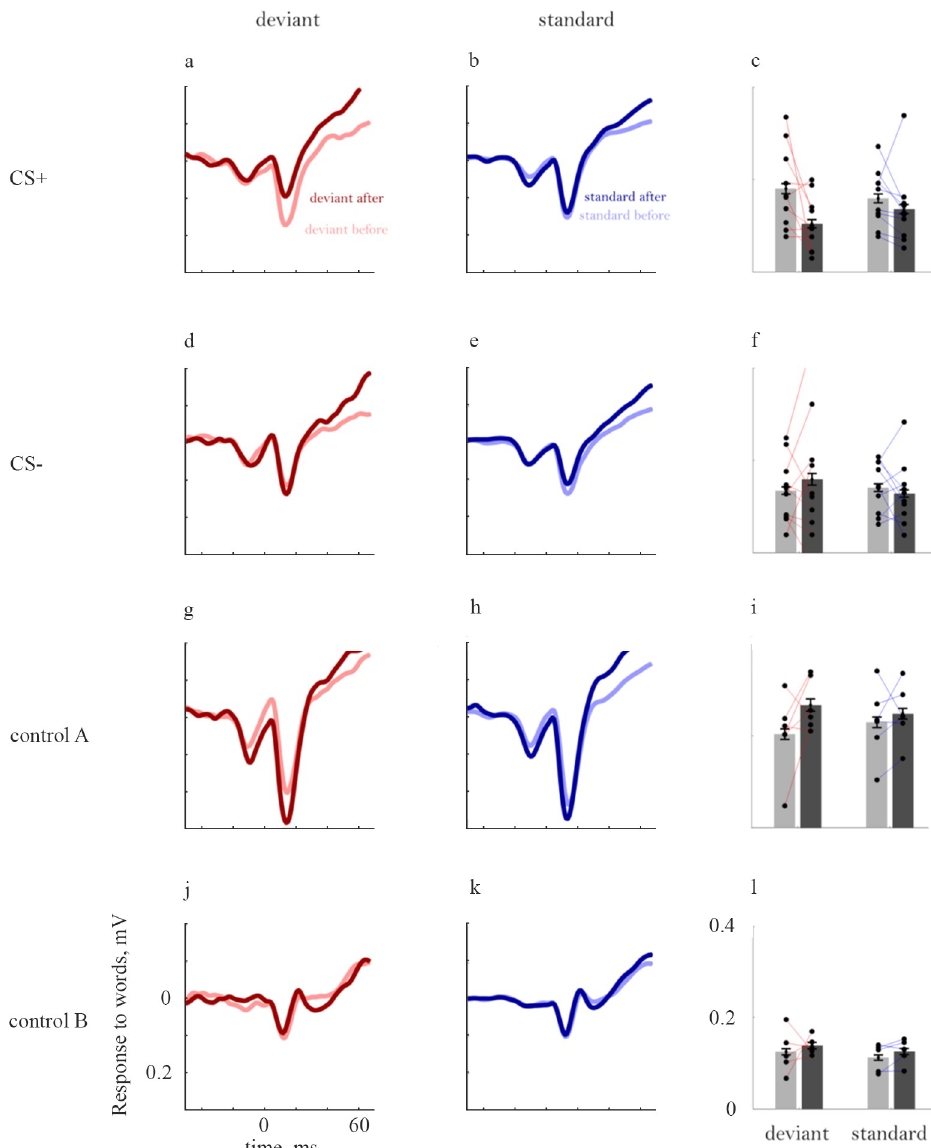
Fig 5. Changes in the responses to word-like stimuli following conditioning. (a) Responses to CS+ word-like stimuli when deviants. The light red line shows the grand mean response when these stimuli were tested as deviants before conditioning. During conditioning, the same word-like stimuli were used as CS+. The dark red line shows the responses to the same stimuli when tested again as deviants after conditioning. time 0 is the onset of the first vowel (2 nd red line in Fig 3). (b) The same, for the responses to the CS+ word-like stimuli when tested as standards. (c) Average peak responses to the same stimuli. The bars represent the average peak response before (gray) and after (black) conditioning. The dots represent the average peak response across all electrodes and sessions in each animal. The peak responses before and after conditioning in each individual animal are connected with a line. (d-f) The same, for word- like CS- stimuli. (g-i) The same, for the responses to word-like stimuli tested in rats conditioned with pure tones (Control A). (j-l) The same, for the responses to word-like stimuli tested in pseudo-conditioned rats (Control B). Note that in this case, while the average response (panel j) was slightly smaller after than before conditioning, the average peak response (panel l) was slightly larger. The reason for such discrepancies here and elsewhere is the fact that peak responses were determined in each electrode and animal individually, and therefore could occur at time points that are different than the time point of the average peak response.